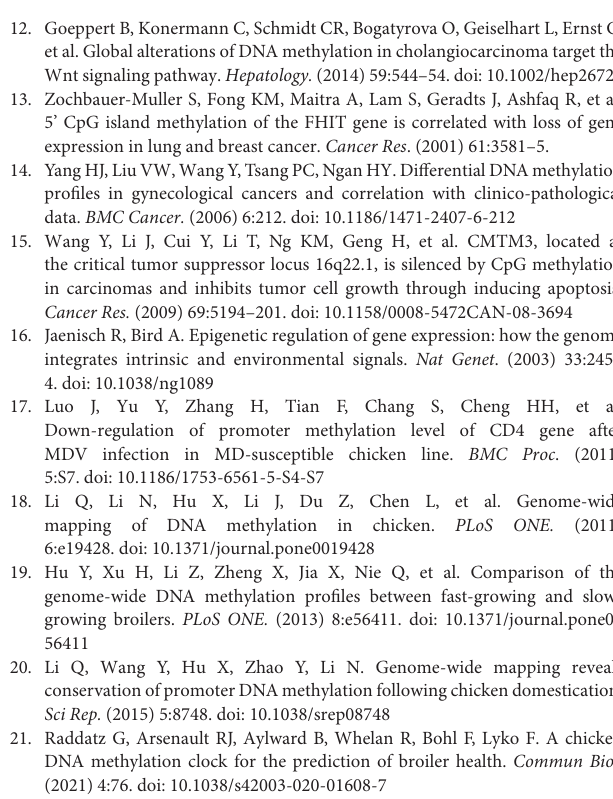
Supplementary Table 8 | Significantly enriched GO categories for DEGs. Supplementary Table 9 | Significantly enriched pathways for DEGs. Supplementary Table 10 | Integrated analysis of MeDIP-seq and RNA-seq data. Supplementary Table 11 | The six genes were reanalyze based on galGal6